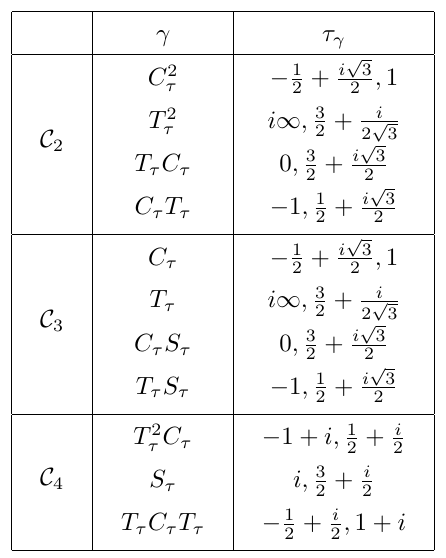
Figure 3 . The fundamental domain D (3) of ¯Γ(3) with the stabilisers of modular transformations of Γ 3 denoted as dots.